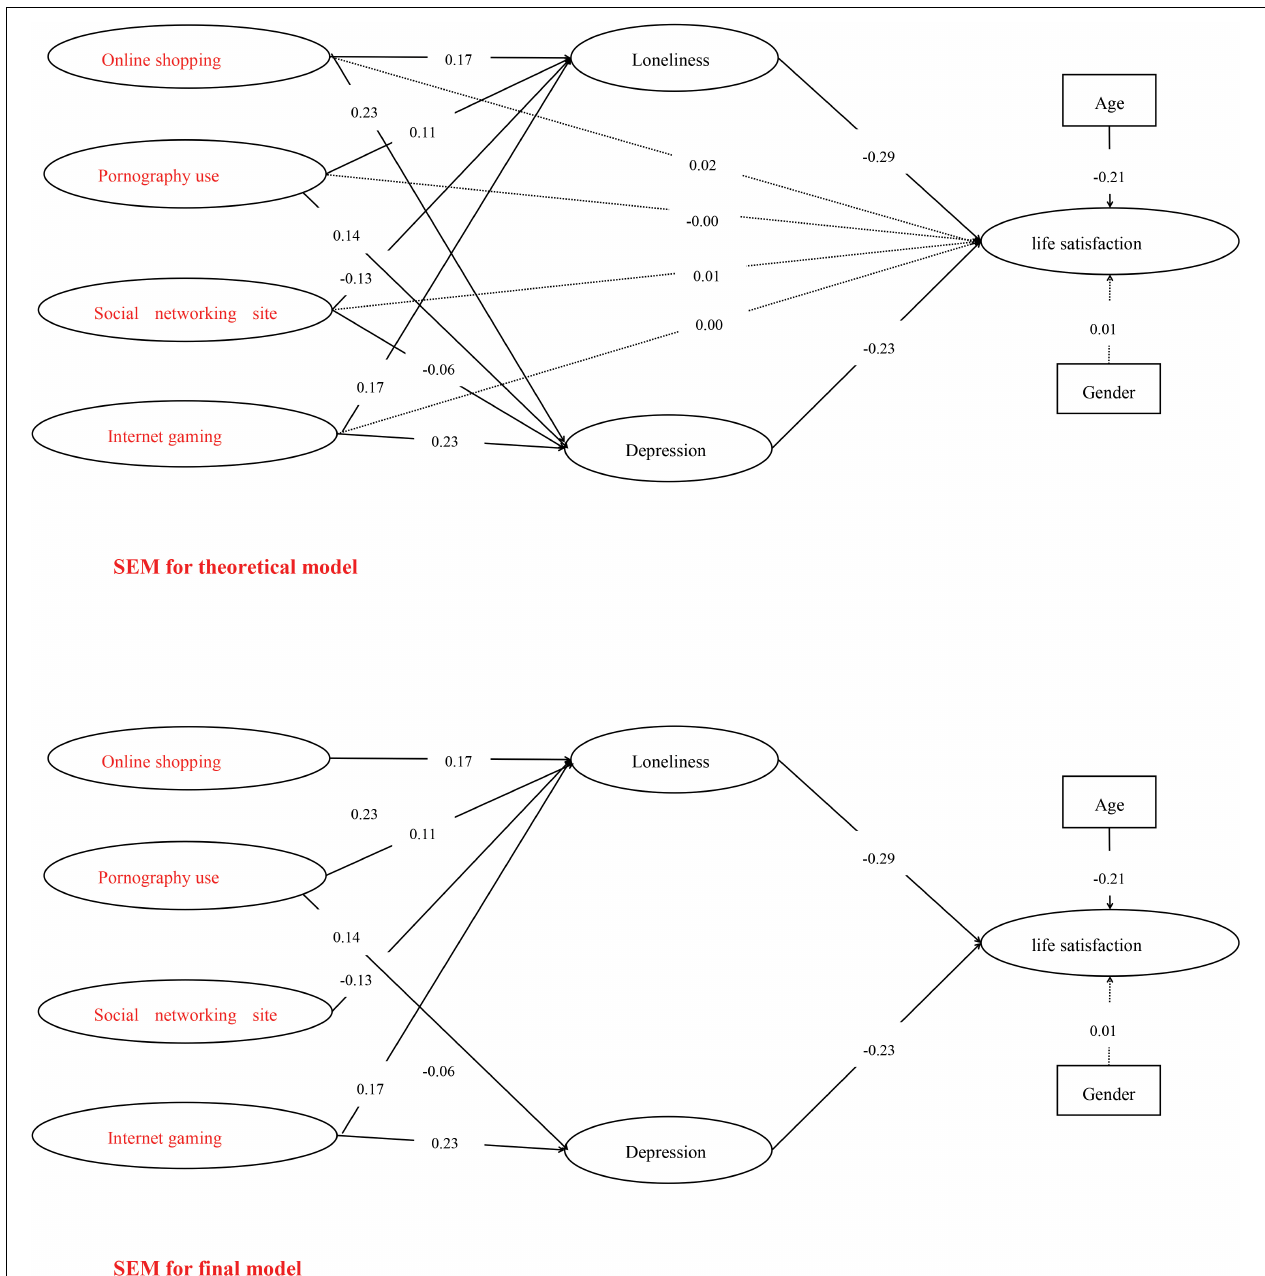
FIGURE 1 | Associations among the studied variables and standardized parameter estimates of the final model. LS, life satisfaction; thick lines represent significant paths (coefficient is significant at the 0.01 level), and dashed lines represent non-significant paths (coefficient is non-significant at the 0.05 level); gender and age were controlled as independent